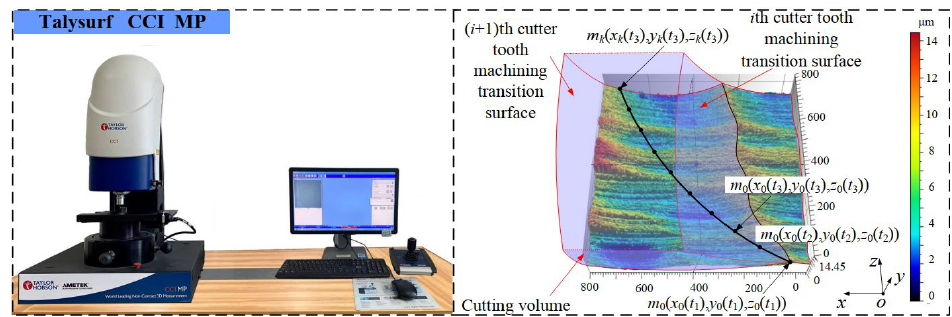
Figure 25. Experimental solution of cutting volume.